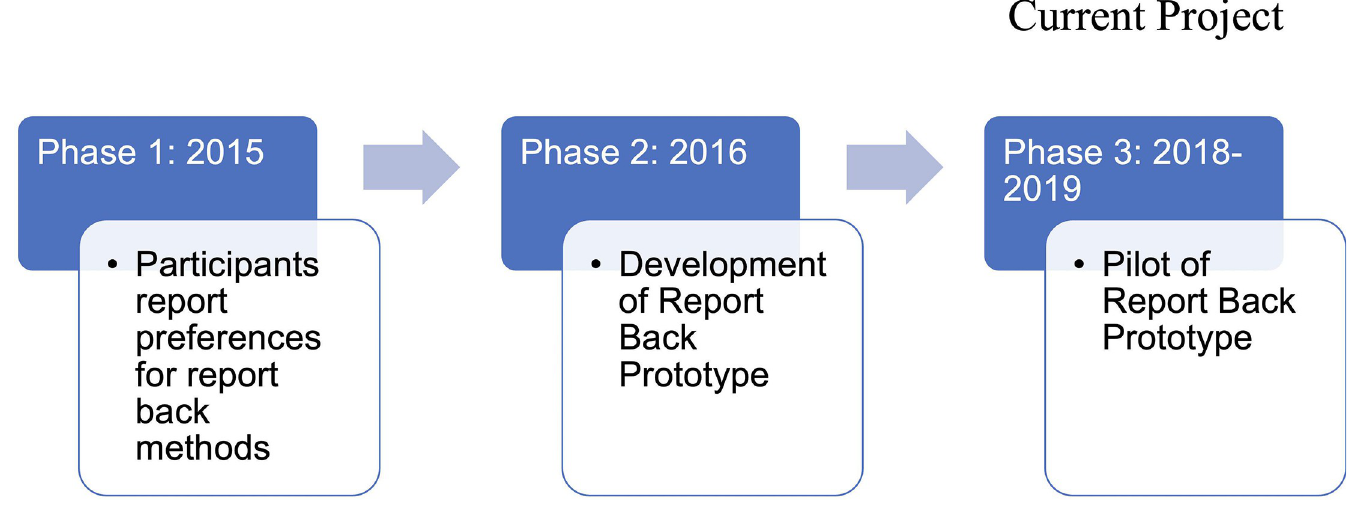
Fig 4. Timeline of Report-Back Process.